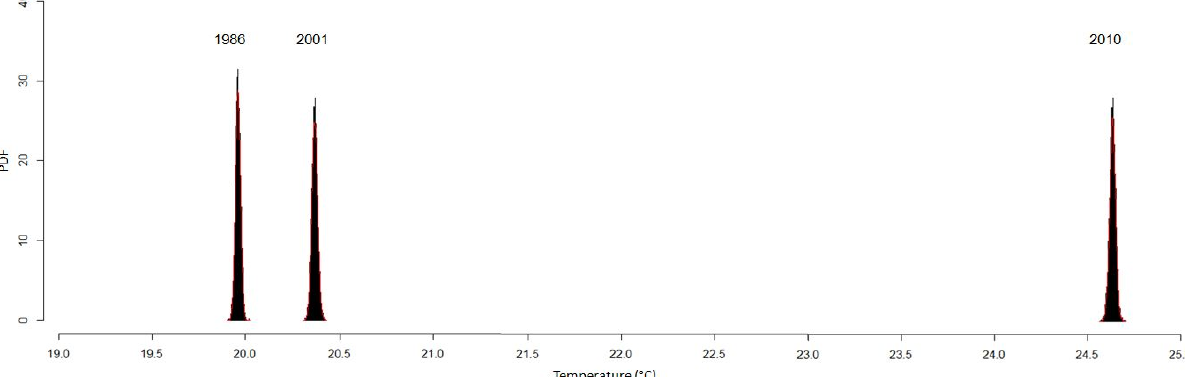
Figure 12. Probability density function calculated from the MCM of land surface temperature.